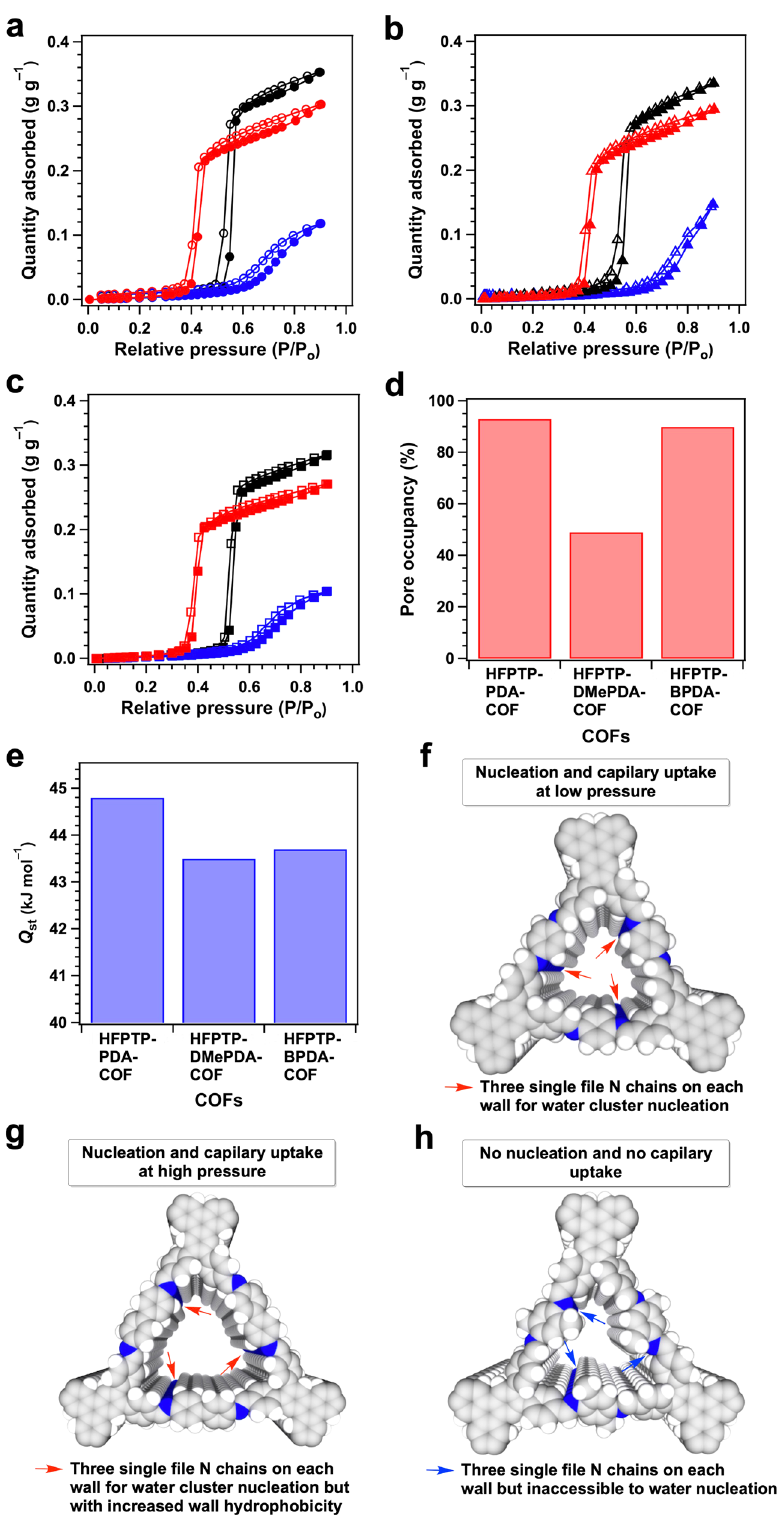
Fig. 3 Water vapour uptake and pore accessibility in trigonal COFs. a Vapour sorption isotherms of HFPTP-PDA-COF (red), HFPTP-DMePDA-COF (blue) and HFPTP-BPDA-COF (black) measured at 25 °C ( fi lled circle – adsorption branch, empty circle – desorption branch). b Vapour sorption isotherms